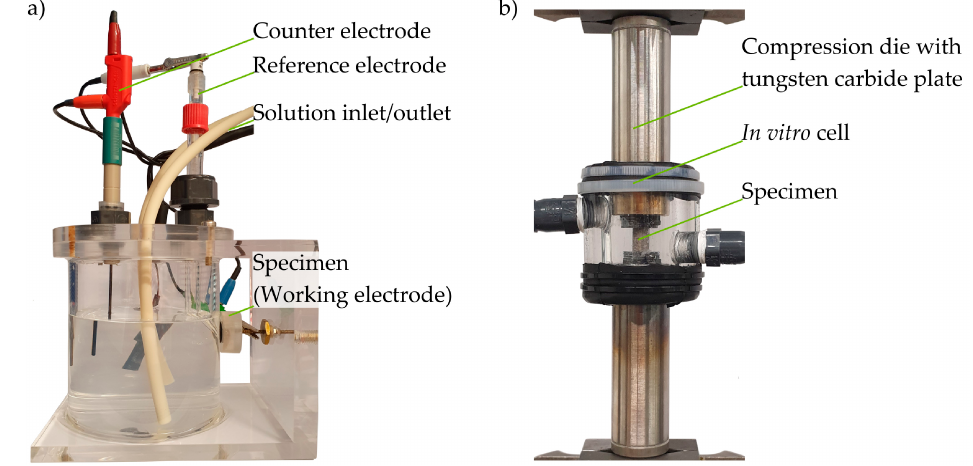
Figure 5. Experimental setup for ( a ) potentiodynamic polarization measurements; ( b ) corrosion fatigue